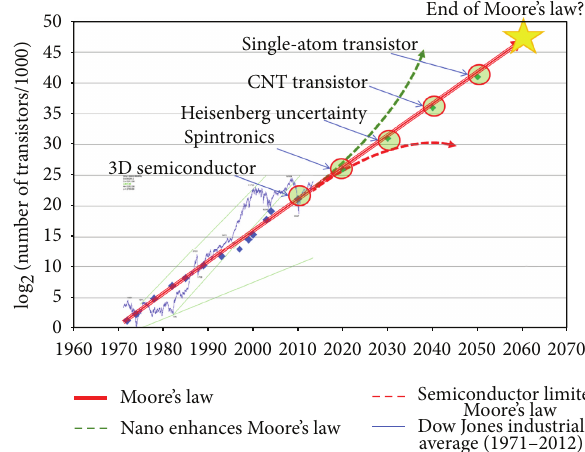
Figure 15: Moore’s Law history, future, limited factors, and Nano- technology-Enhance factors for Moore’s Law and compared with Dow Jones industrial average in the same period of time